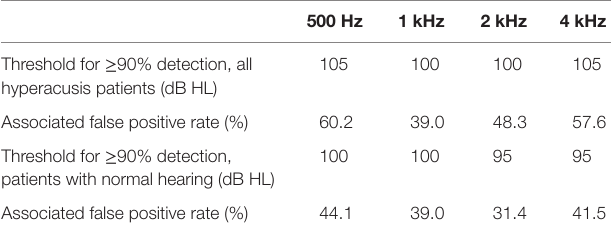
TaBle 2 | lDl threshold values to correctly classify at least 90% of hyperacusis patients and associated percentage of false positives. 500 hz 1 khz 2 khz 4 khz